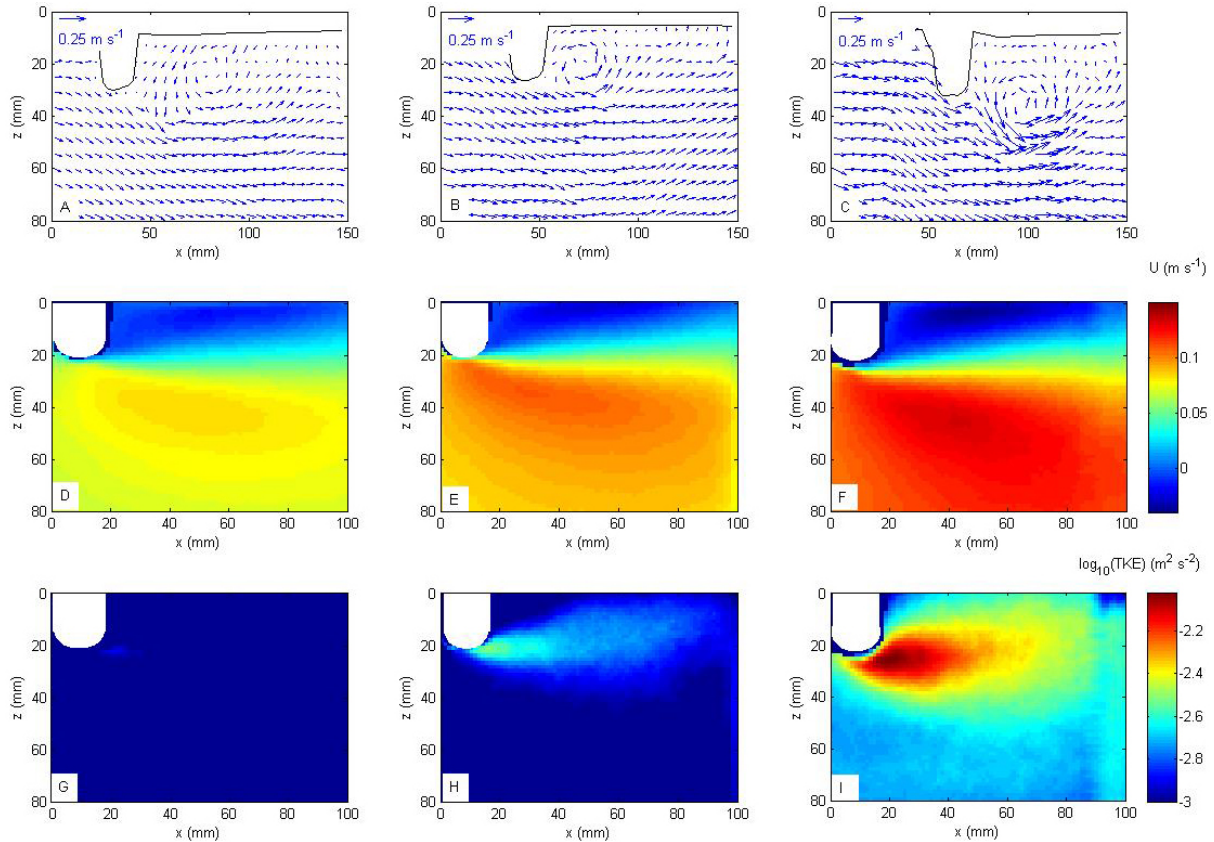
Figure B1. Laboratory measurements of flow velocity and turbulence under anchored chambers at different mean current speeds (left: 0.06ms − 1 , middle: 0.08ms − 1 , right: 0.10ms − 1 . Panels (a–c) show examples of instantaneous velocities around the leading edge of the chambers. The water surface and the leading chamber edge are marked by solid black lines. (d–f) Temporal mean longitudinal flow velocity ( U ). (g–i) Mean turbulent kinetic energy (TKE). The chamber edges are masked out (white) and regions without sufficient obser- vations (<90s for the anchored cases) are displayed in dark blue. The direction of flow was from left to right; x and z refer to longitudinal distance and depth,